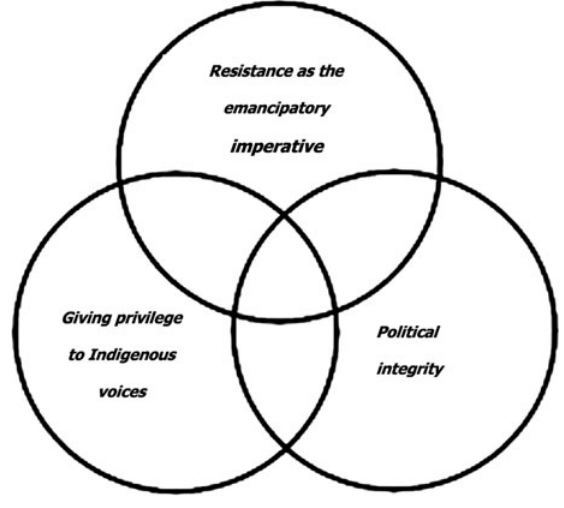
Rigney’sthreeIndigenistResearchPrinciples.Adaptedfrom‘Interna- tionalisationofanIndigenousanticolonialculturalcritiqueofresearch methodologies: A guide to Indigenist Research Methodology and its principles’, by Rigney